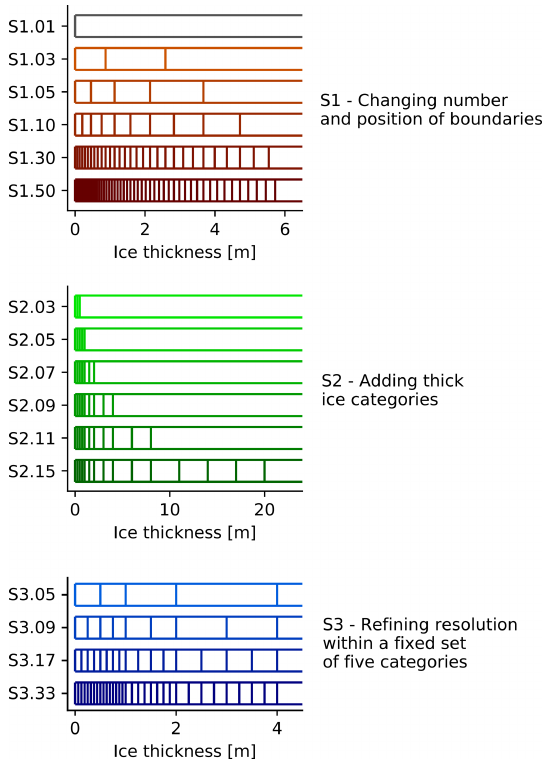
Figure 1. Boundaries of the ice thickness categories in the three sets of sensitivity experiments. The last category’s upper boundary is al- ways set as 99m thick. The thickness scale changes across the three panels. Because the third ITD discretization, S3, branches from the experiment S2.09, we repeat the latter on the bottom panel but re- named as S3.09. Figure is adapted from Massonnet et al.